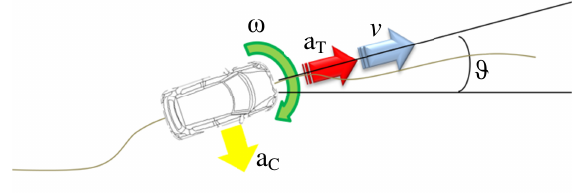
Figure 7. Variables in use in the motion